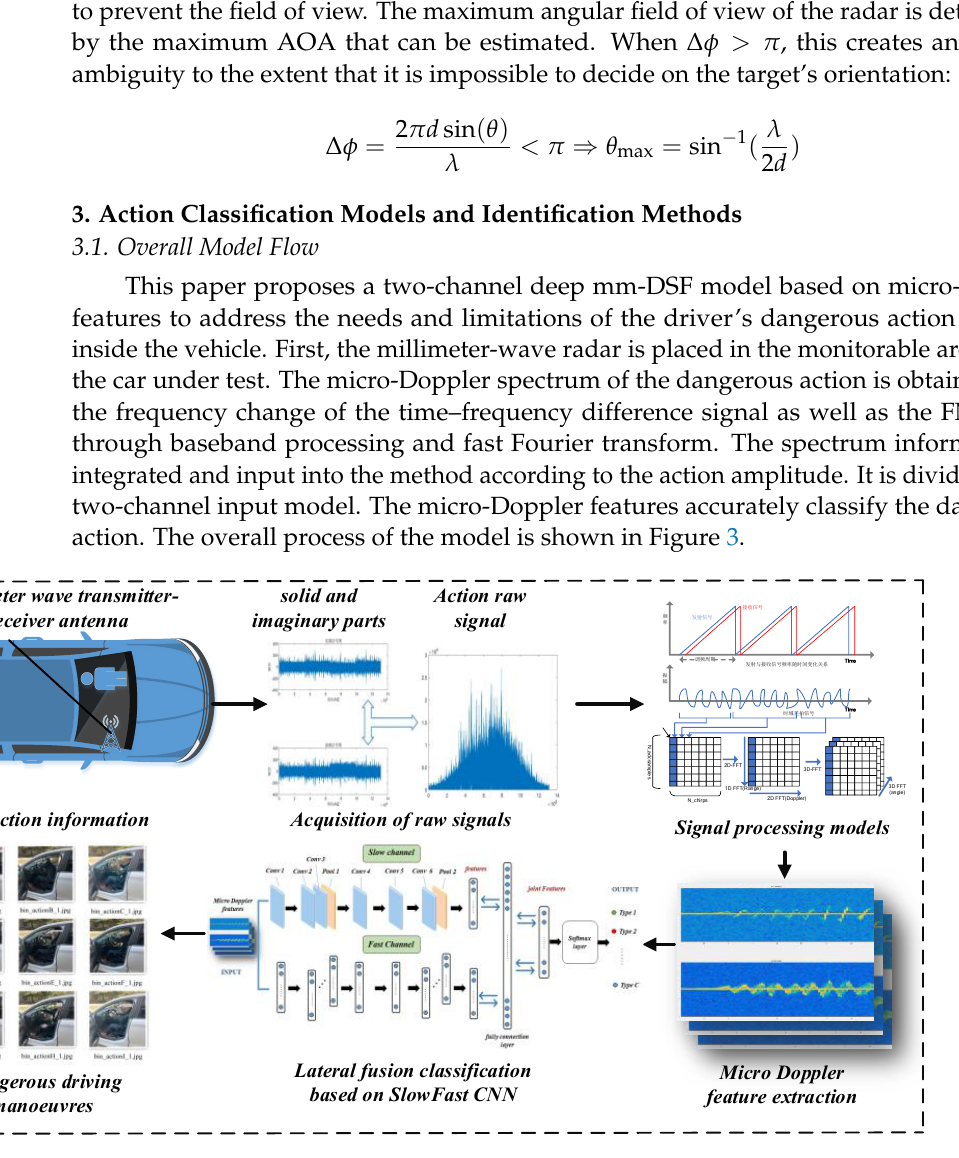
Figure 3. Overall flow chart of the mm-DSF model.